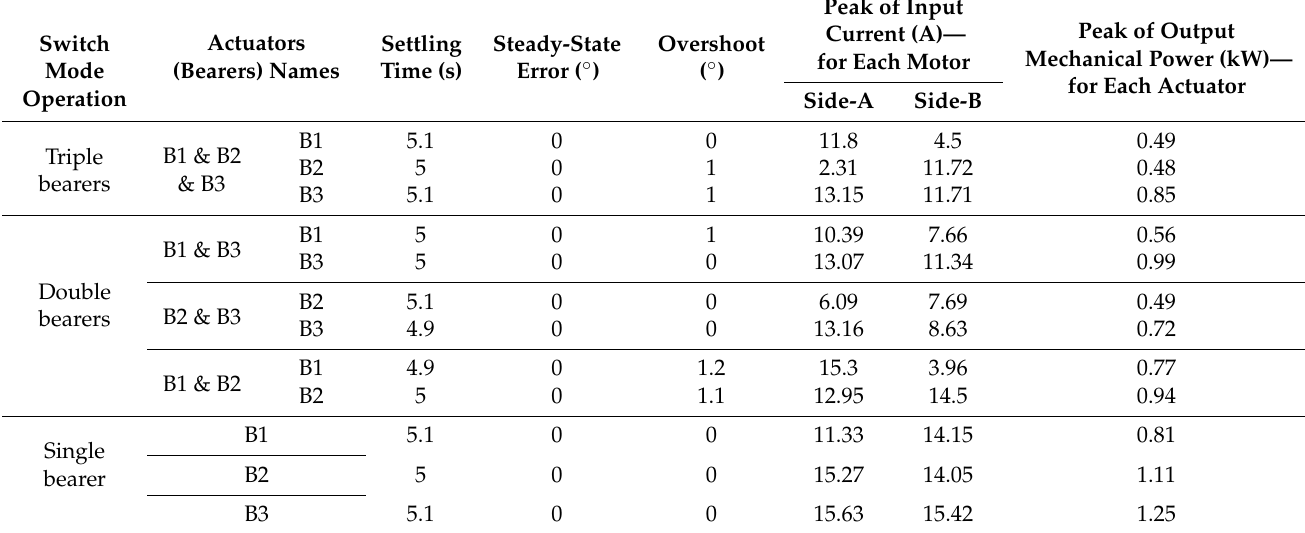
Table 3. Closed-loop performance under fault-free (triple), one out of three faults (double) and two out of three faults (single)